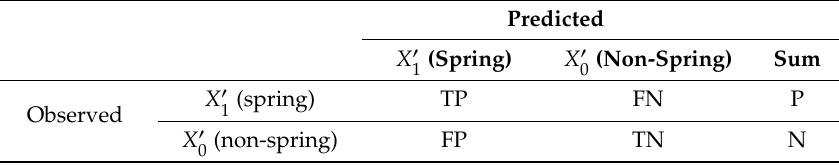
Table 3. Confusion matrix. Abbreviations: TP, number of pixels correctly classified as positive (springs) predictions; TN, number of pixels correctly classified as negative (non-springs) predictions; FP, number of pixels incorrectly classified as positive (springs) predictions; FN, number of pixels incorrectly classified as negative (non-springs) predictions.